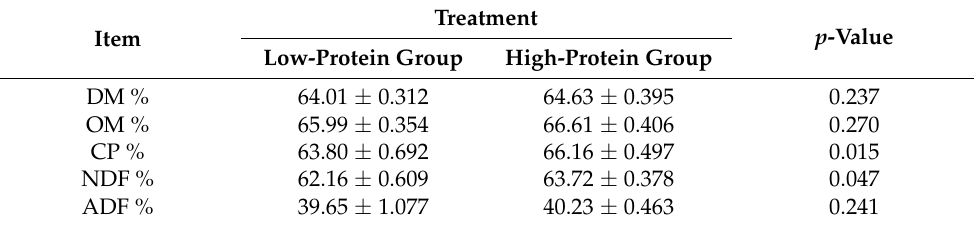
Table 3. Effects of the dietary protein level on the nutrients’ apparent digestibility of growing yaks.